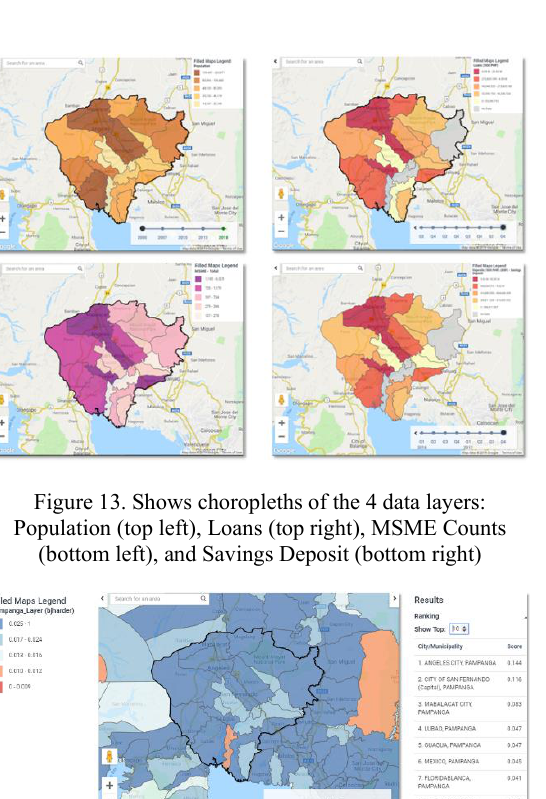
Figure 11. Shows the POI Profile screen of the Gateway Area Report.